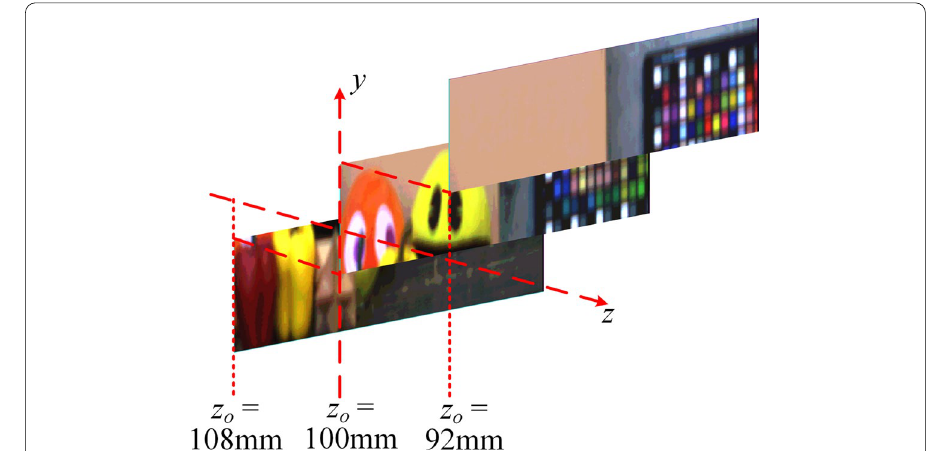
Fig. 9 The layout of input datacube (Single spectral image at 570